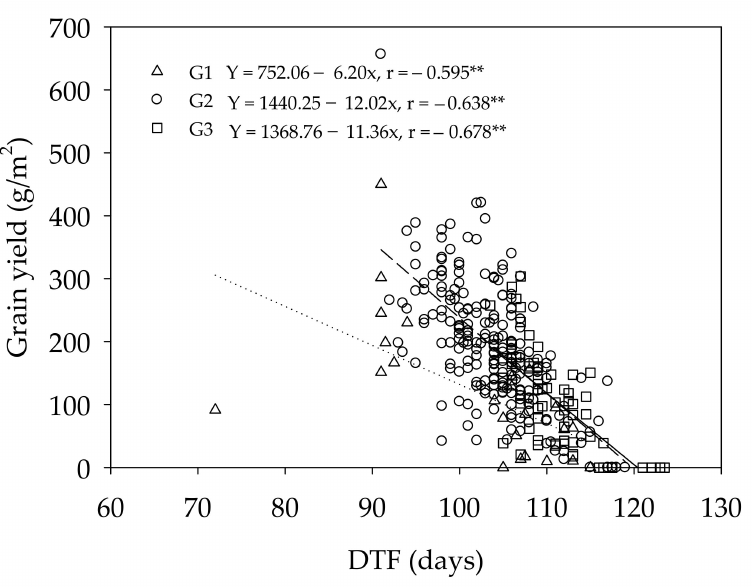
Figure 4. Relationship between DTF and GY in each group. G1 represents insensitive to the photope- riod, G2 weakly sensitive, G3 strongly sensitive, ** represents significance levels at p < 0.01.